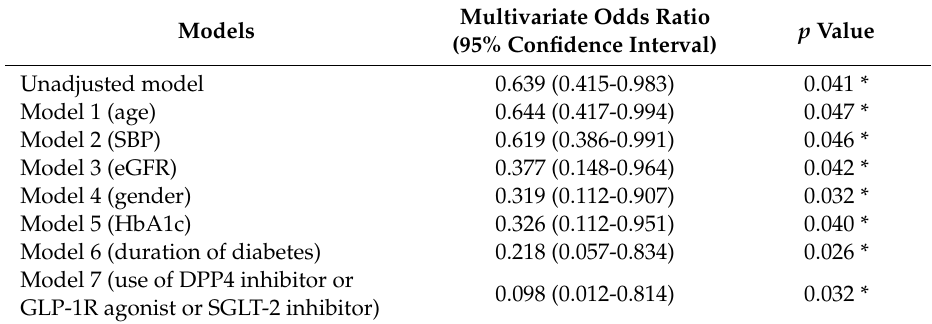
Table 4. Kynurenine to tryptophan ratio (KTR) showed a significant association with. ARB responsiveness in diabetic patients with macroalbuminuria after adjusting with other confounding factors.